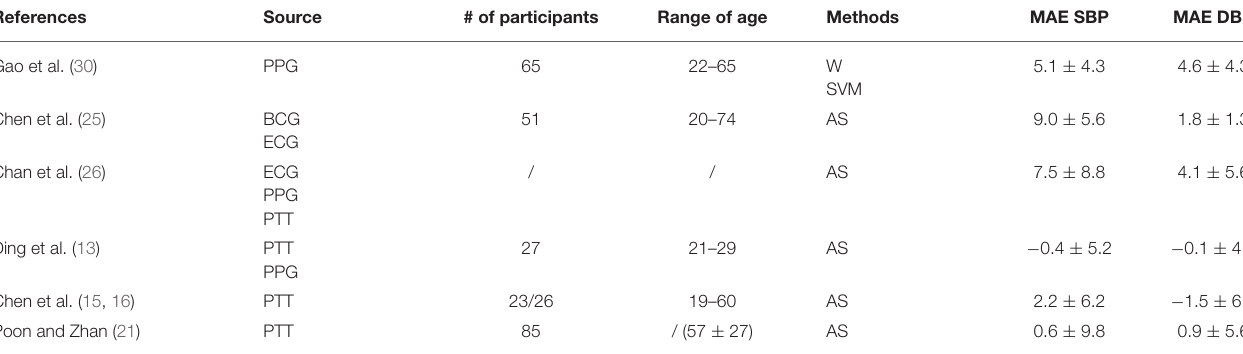
TABLE 1 | Prior non-invasive cuffless blood pressure estimation studies.